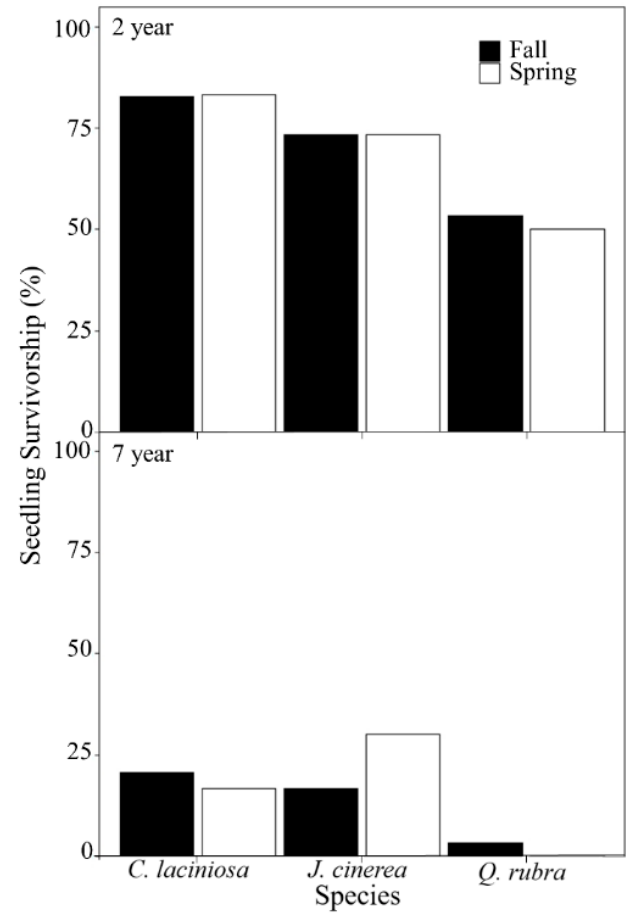
Figure 5. Percent survival of seedlings as a function of planting season for three tree species that were either planted in the fall (black) or the spring (white) in a temperate forest understory in southwestern Ohio, USA, during a forest restoration experiment. There were no statistically significant di ff erences in survivorship among planting seasons for any species after 2 years of growth ( p > 0.05) or for C. laciniosa or Q. rubra after 7 years ( p > 0.05), but J. cinerea seedlings had higher survivorship when planted in the fall after 7 years of growth ( p = 0.022).